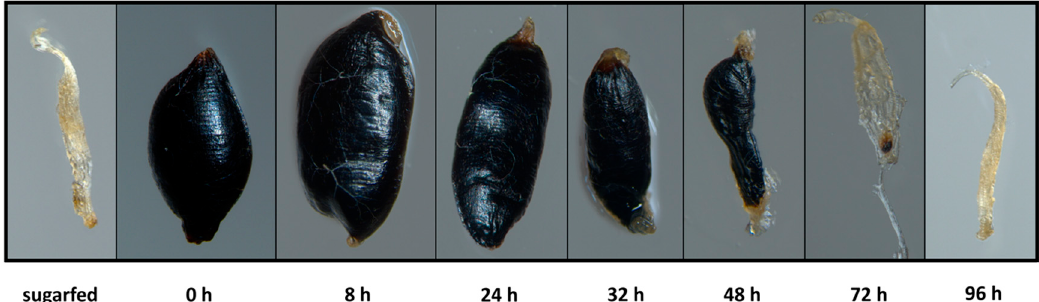
Figure 1. Visual comparison of bloodmeal digestion over time in the midgut of Aedes aegypti . One week-old Higgs White Eye (HWE) females ingested an artificial bloodmeal consisting of undiluted defibrinated sheep blood. Light microscope magnification: 30×.